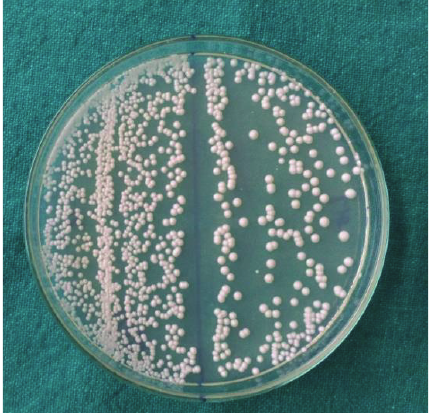
Figure 1: Candidal growth on SDA.